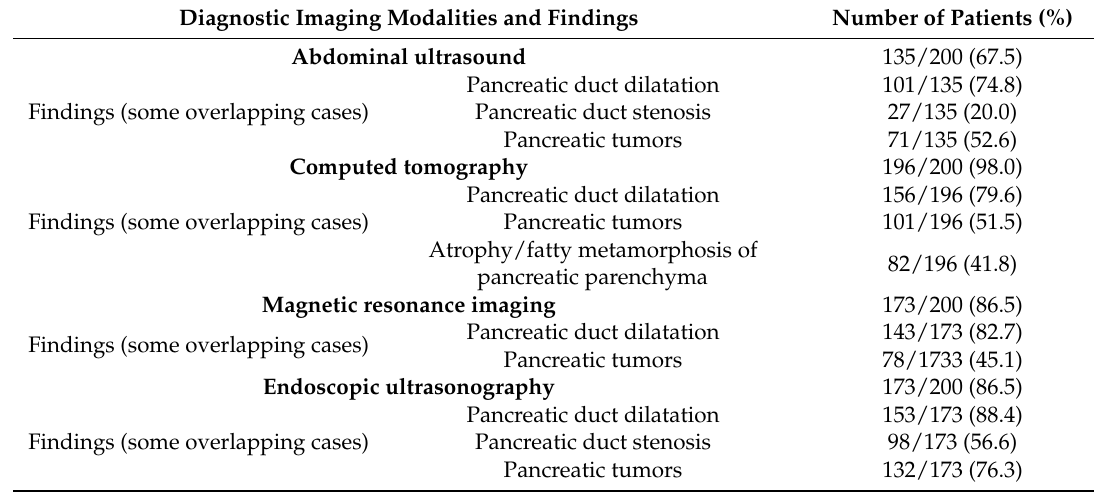
Table 4. Diagnostic imaging findings (quoted from Reference [23]).